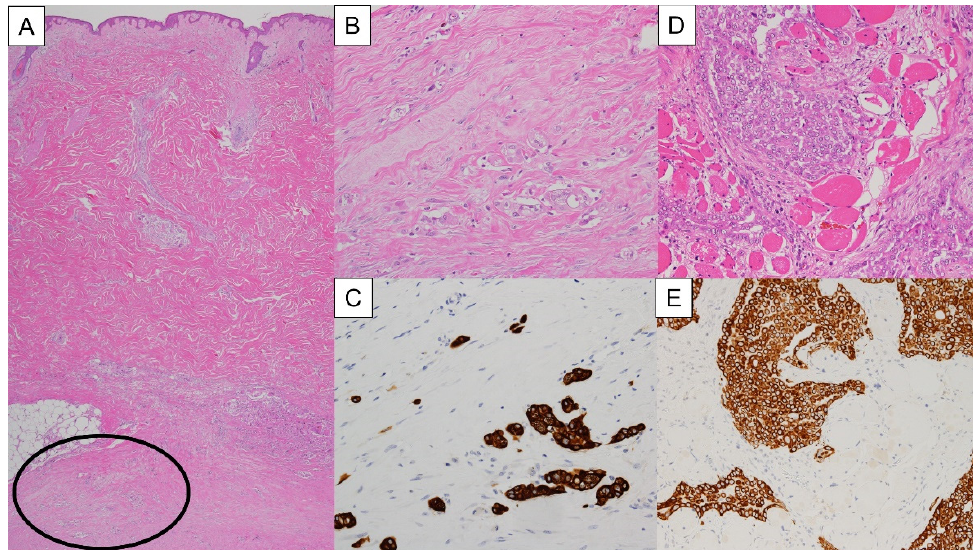
Figure 2. Histopathology of biopsy sites of the chest wall. Atypical cells are invading into the subcutaneous tissue at the biopsy site (circle) ( A ). An enlarged image of the circle in Figure 2A ( B ). AE1/AE3 immunostaining of a section adjacent to Figure 2B, indicating that.AE1/AE3-positive atypical cells, mesothelioma cells, are invading into the subcutaneous tissue at the biopsy site as small cellular aggregates ( C ). Atypical cells are invading into the skeletal muscle of the chest wall at the biopsy site ( D ). AE1/AE3 immunostaining of a section adjacent to Figure 2D, indicating that AE1/AE3-positive atypical cells, mesothelioma cells, are invading into the skeletal muscle of the chest wall at the biopsy site as cell clusters ( E ). ( A , B , D ) are stained with hematoxylin and eosin. ( A – C ) are histopathological images of one patient, and ( D , E ) are histopathological images of another patient .